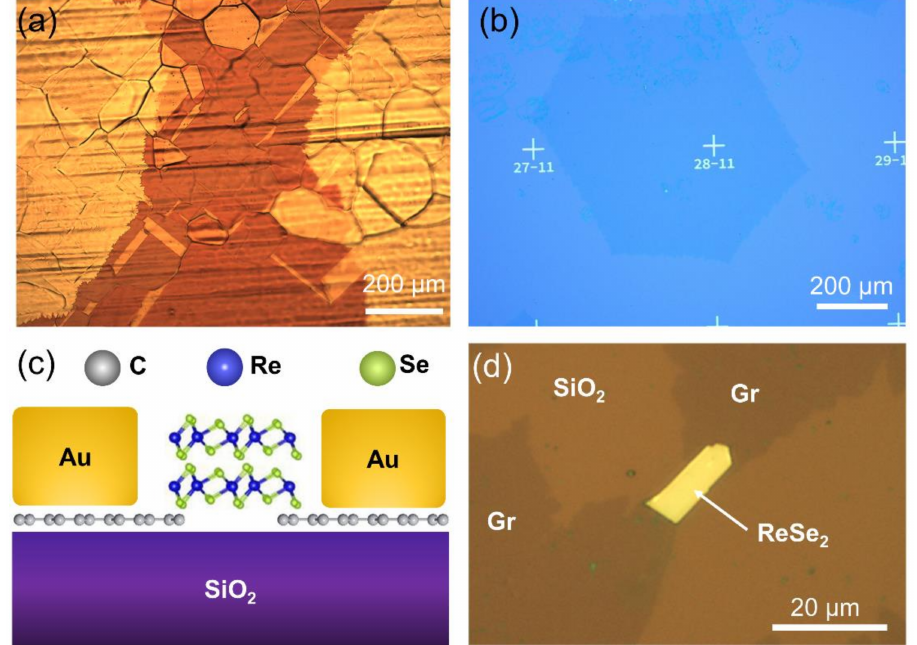
Figure 3. ( a ) GSCs grown by CVD on Cu substrates, which was oxidized after growth to enhance the contrast between GSC and substrate ( b ) The GSCs were transferred onto Si/SiO 2 wafer. ( c ) Schematic side-view and ( d ) optical top-view image of the GSC/ReSe 2 photodetector device. The ReSe 2 channel has ~5 µ m